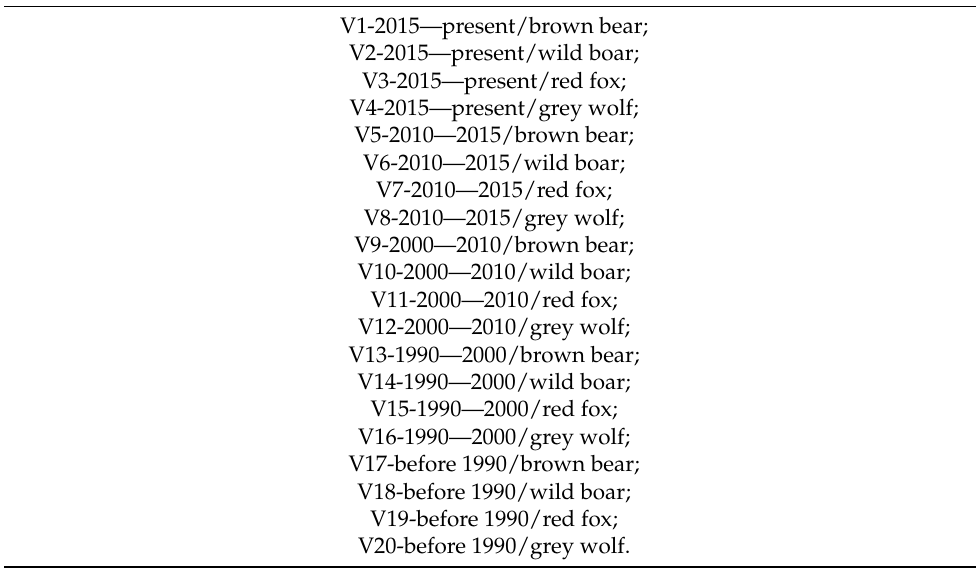
Table A4. Cont. Presence and Absence of Species within a Specific Time Period—Response